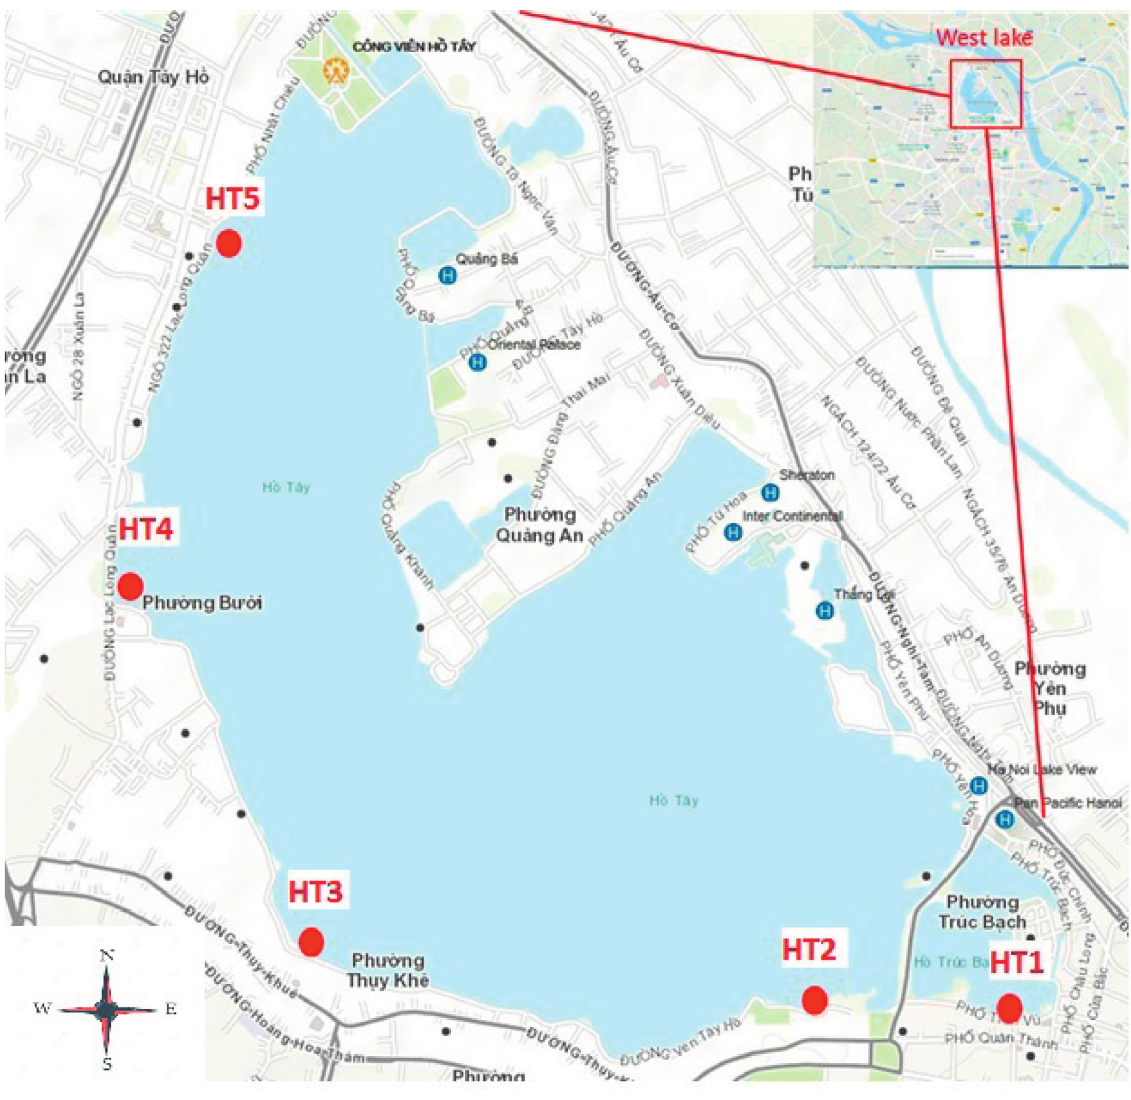
Figure 1: Surface water sampling points at the West